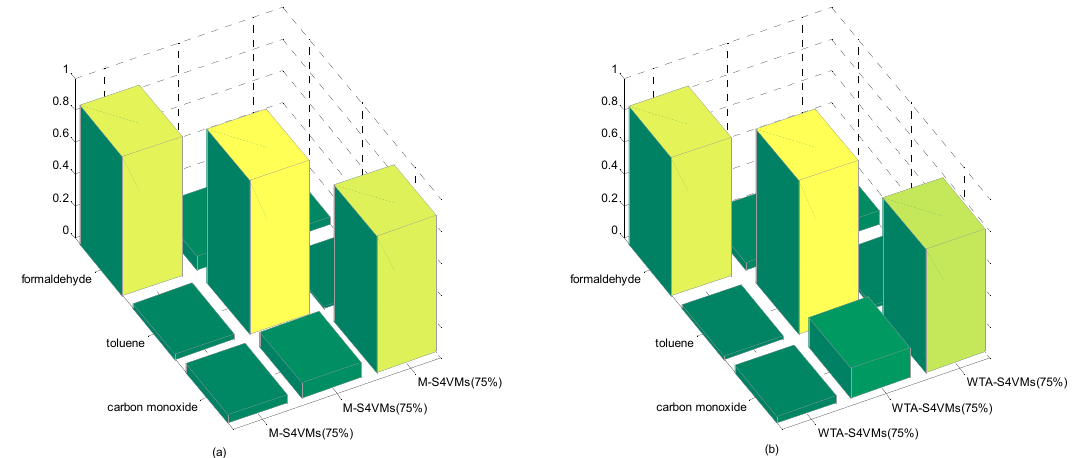
Figure 5. 25% unlabeled rate of the two methods. It illustrates the classification results based on three target gases by M-S4VMs ( a ) and WTA-S4VMs ( b ) when the unlabeled data account for 25%. According to the figure, it is clear that M-S4VMs gets better accuracy rate than WTA-S4VMs in 25% unlabeled rate.